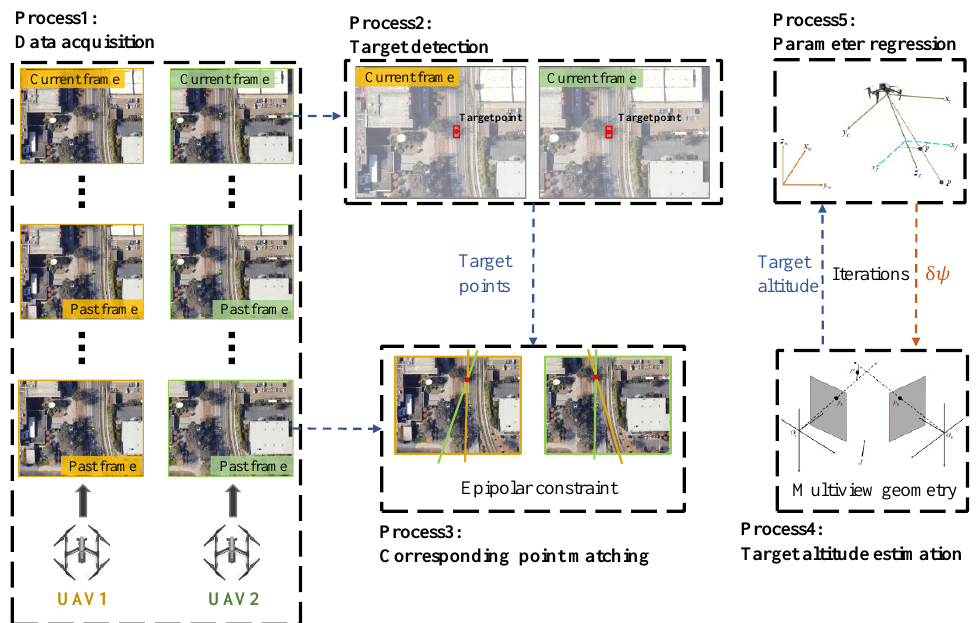
Figure 2. Overview of the proposed moving-target geolocation framework using dual